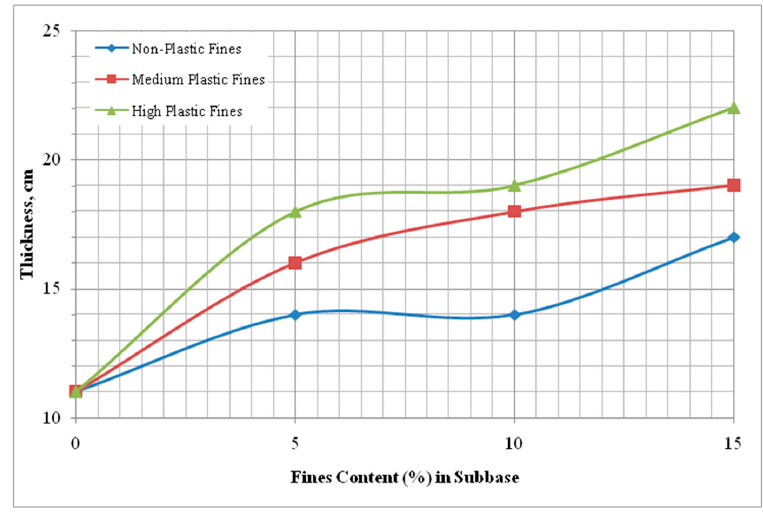
Figure 8. Base thickness with the use of composite samples (gradation B).